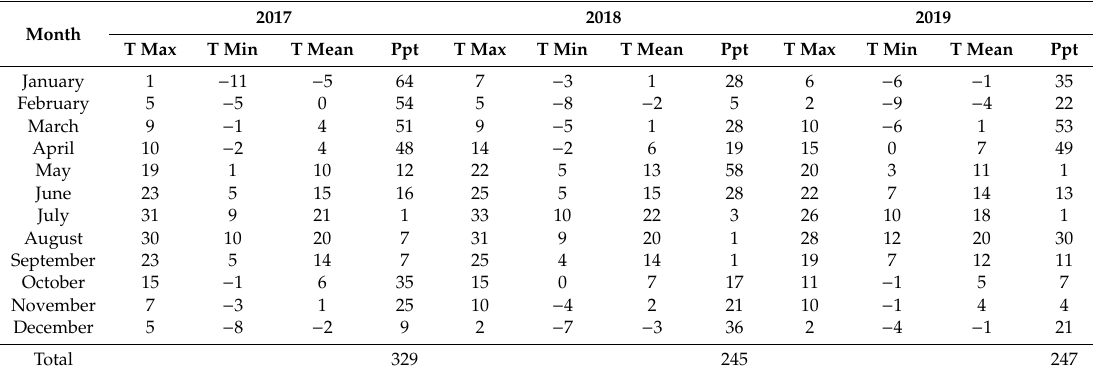
Table 6. Monthly averaged maximum (T Max), minimum (T min), and mean (T mean) air temperature in Celsius degrees, and total monthly and annual precipitation (Ppt) in mm at the CCPWS site for the three-year (2017–2019) duration of the study.